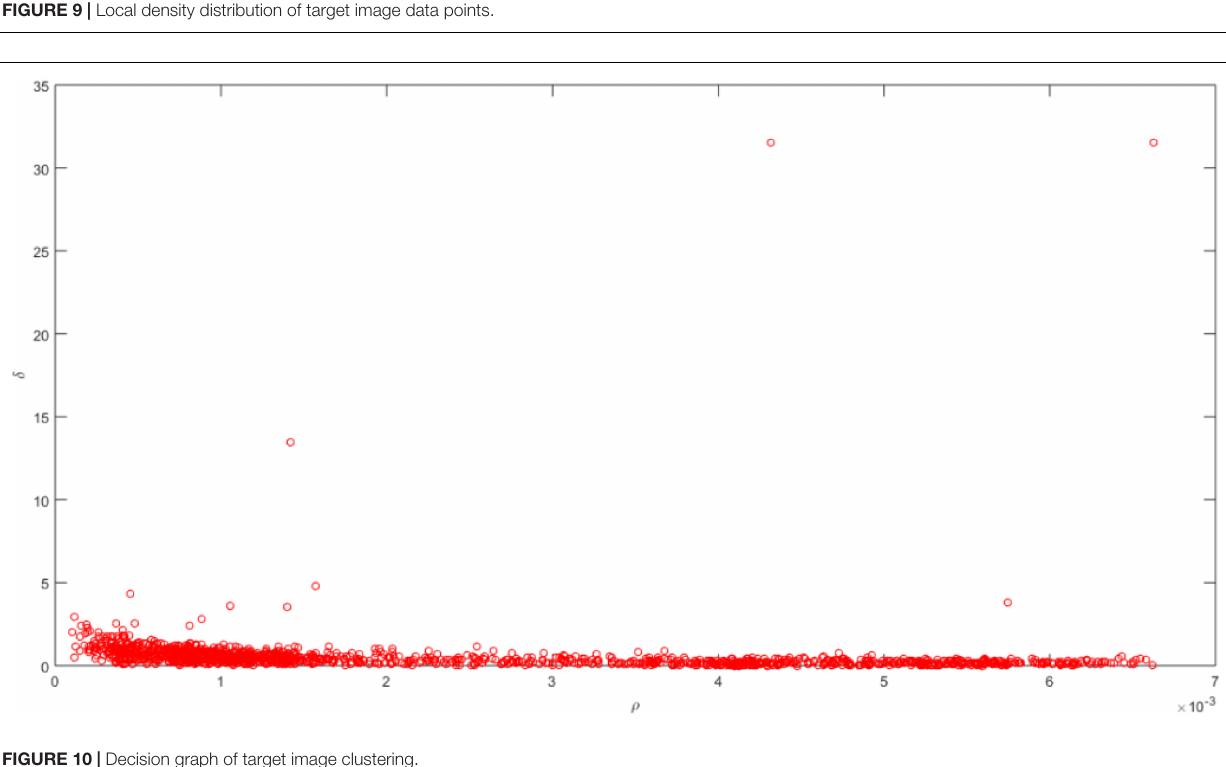
FIGURE 10 | Decision graph of target image